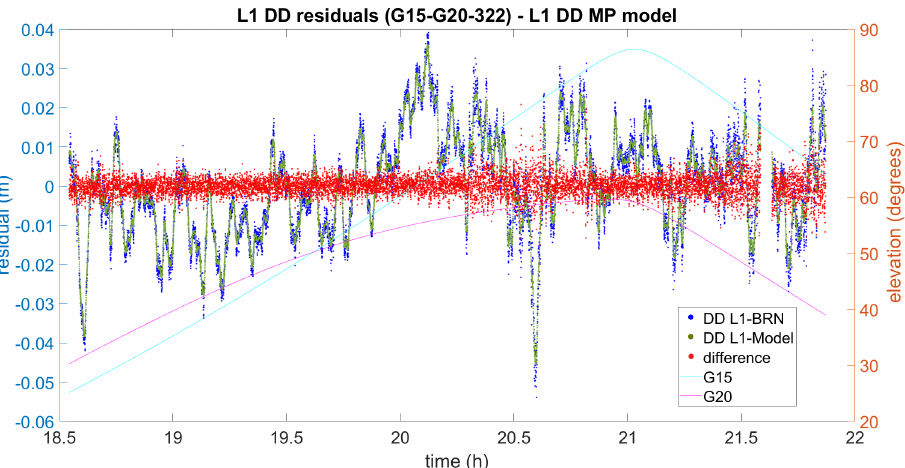
Figure 7. The result of L1 DD multipath mitigation for satellites G15 and G20 (2016 DOY322). DD L1-BRN and DD L1-Model denote the DD L1 residuals obtained by means of Bernese and the use of the Model,